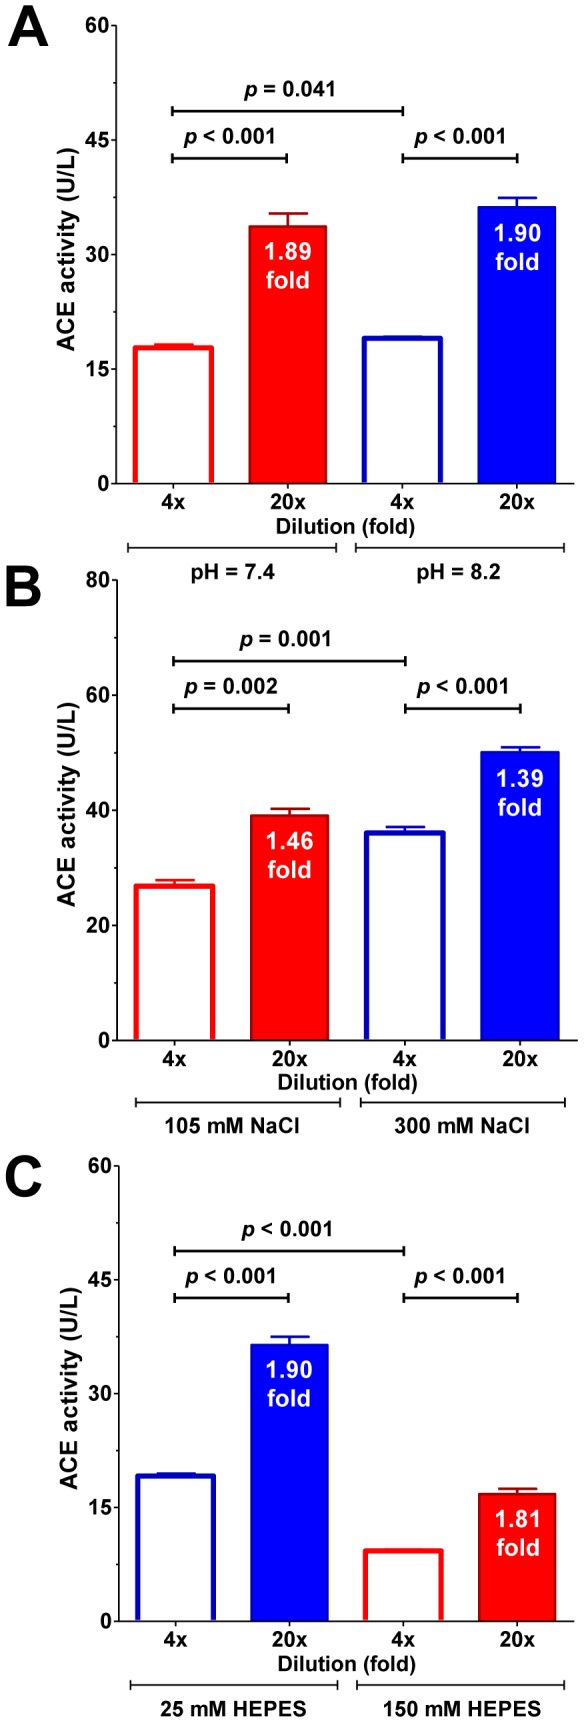
Differences in pH, ionic strength and buffer concentration do not effect the increase in ACE activities upon dilution.Effects of dilution (4 and 20-fold) were tested on ACE activity under different assay conditions. Increase in specific ACE activity was present at physiological pH (A), at physiological Cl− (B) and at higher buffer concentrations (C). Blue bars represent optimal assay conditions used in the previous experiments. Bars denote means ± SEM of at least 3 determinations. Significant differences are indicated by the p values. The increase in ACE activities for each pairs are also shown within the bars.